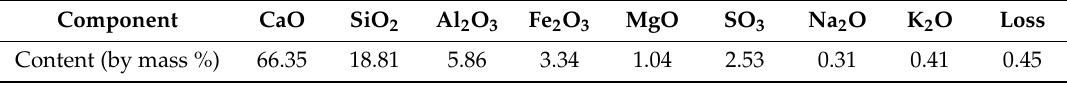
Table 1. Chemical composition of the